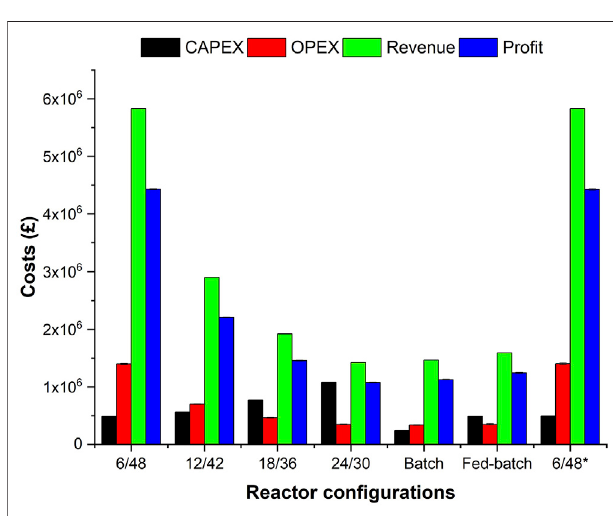
FIGURE 3 | Financial analysis (CapEx, OpEx, revenue, and pro fi t) of investigated con fi gurations at demonstraition-scale. Error bars represent the standard deviations between averaged OpEx and pro fi t with and without electricity cost